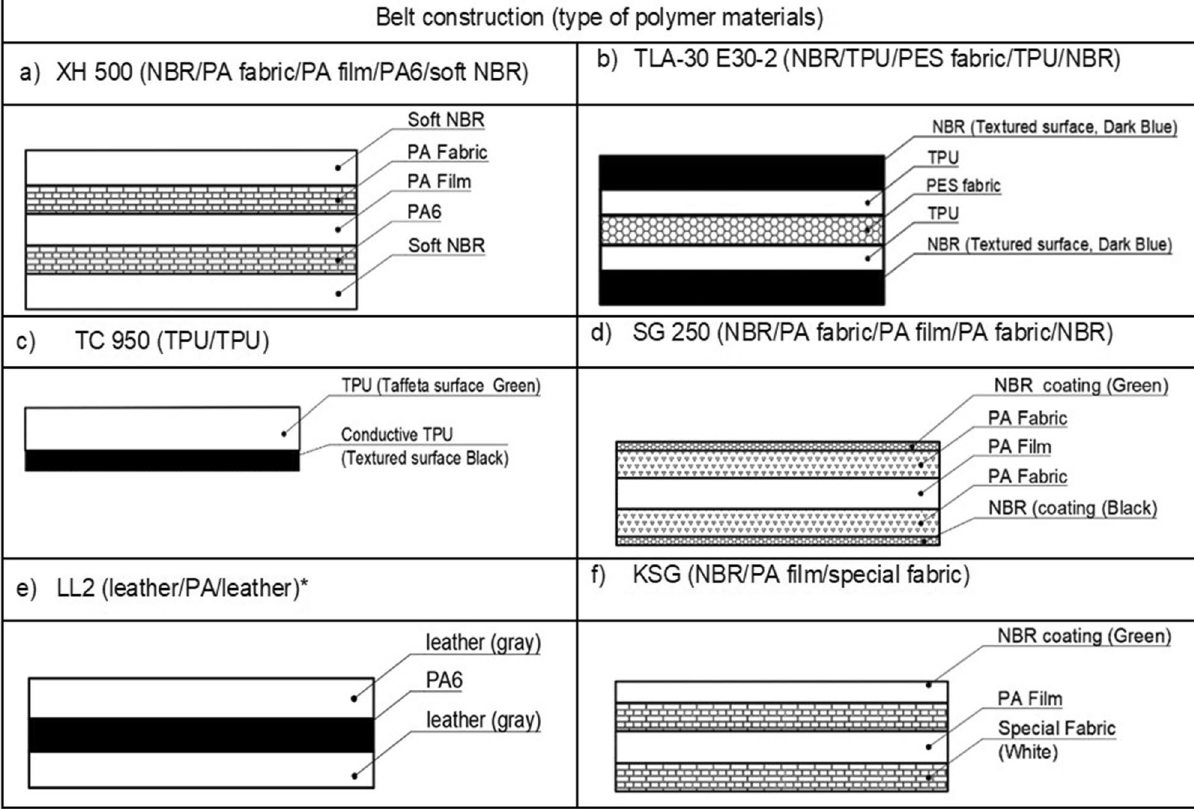
Table 1. Markings and construction of the tested flat multilayer belts 29,30